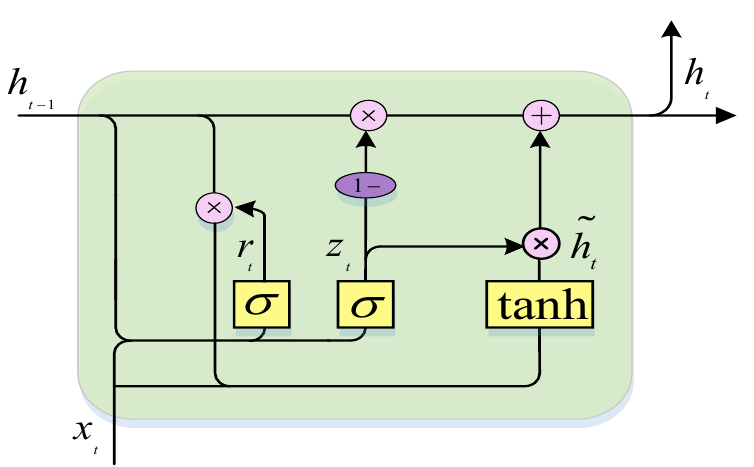
Figure 9. The basic structure of Gated Recurrent Unit.